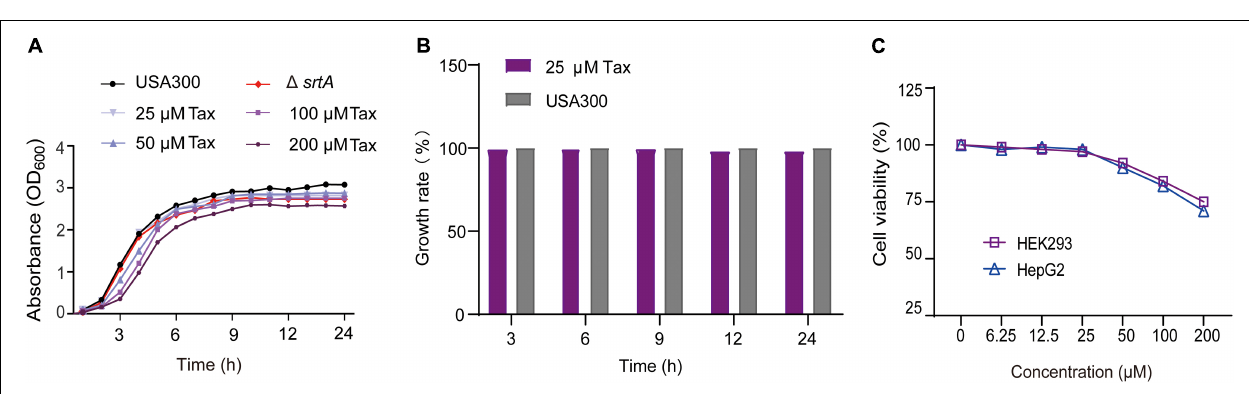
FIGURE 2 | Growth curve and cytotoxicity. (A) Growth curves of S. aureus USA300 and the (cid:49) srtA group with different concentrations of Tax. (B) Growth rate of S. aureus USA300 and S. aureus treated with Tax (25 µ M). (C) Percent cell viability of HEK293 (purple) and HepG2 (blue) cells were measured using a CCK-8 assay after incubation with Tax for 24